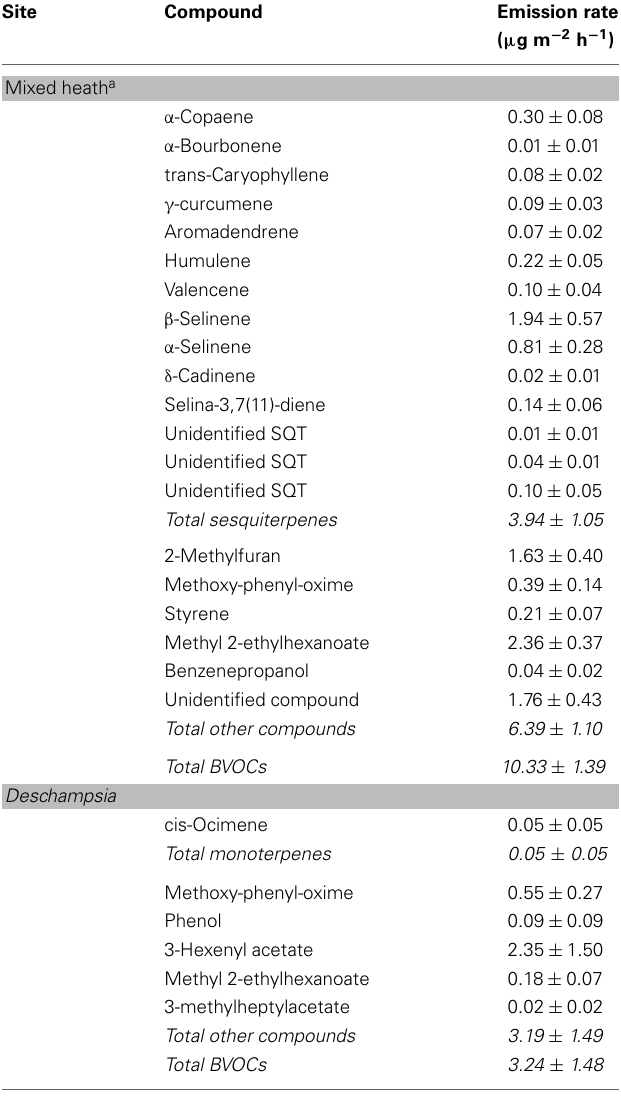
Table 1 | Emission rates (mean ± SE) of biogenic volatile organic compounds emitted from the mixed heath and Deschampsia mesocosms with intact